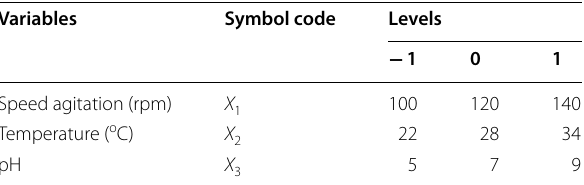
Table 1 Variables values of a 2 3 factorial design with centered face and three repetitions at the central point used to evaluate the influence of (X ) speed 1 agitation, (X ) temperature and (X ) pH on 2 3